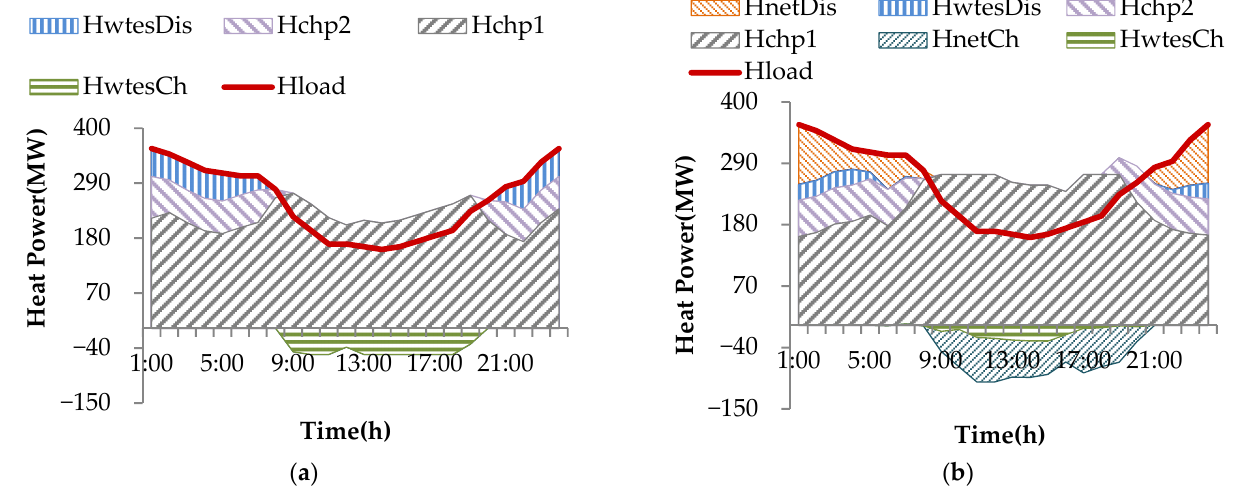
Figure 6. Optimal results of heat power scheduling on a typical day: ( a ) S3 and ( b ) S4.